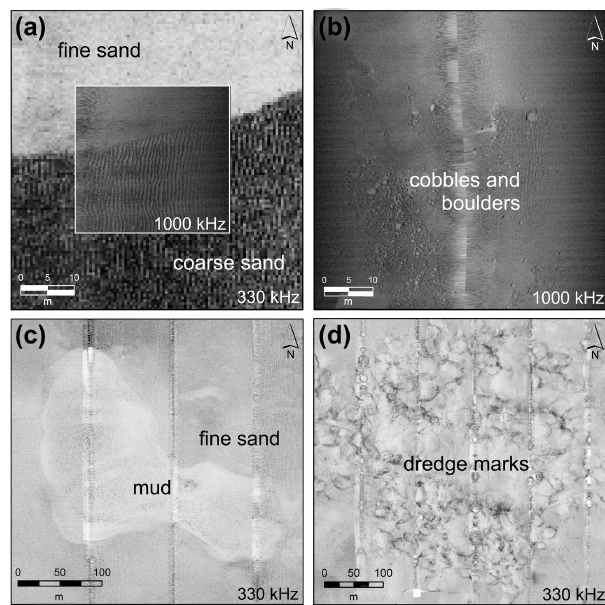
Figure 3. Seafloor features detected within the two side-scan sonar mosaics: (a) rippled coarse sand (dark) and smooth fine sand (bright) demarcated by a sharp border. (b) Cobbles and boulders. In the direction of the sonar source, these objects initially exhibit high backscatter followed by a bright acoustic shadow from which no backscatter can occur. (c) Very smooth mud area with low backscat- ter surrounded by a domain of fine sand with intermediate backscat- ter. (d) Cone-shaped funnels representing the dredging marks on the seafloor. Since higher backscatter values occur on the slopes of the funnels that are directed towards the sonar source, differences in sediment distribution are not distinguishable using hydroacoustics.